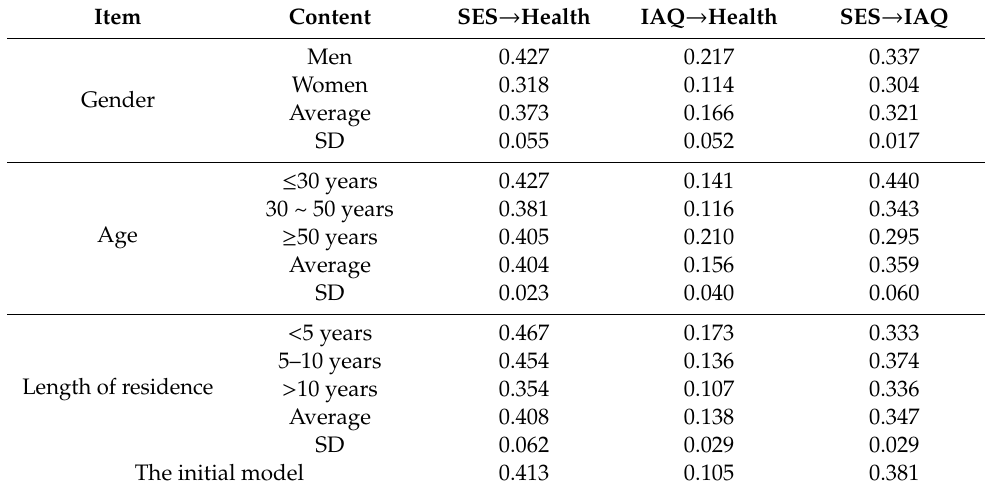
Table 6. The distributions of path coe ffi cients for gender, age, and length of